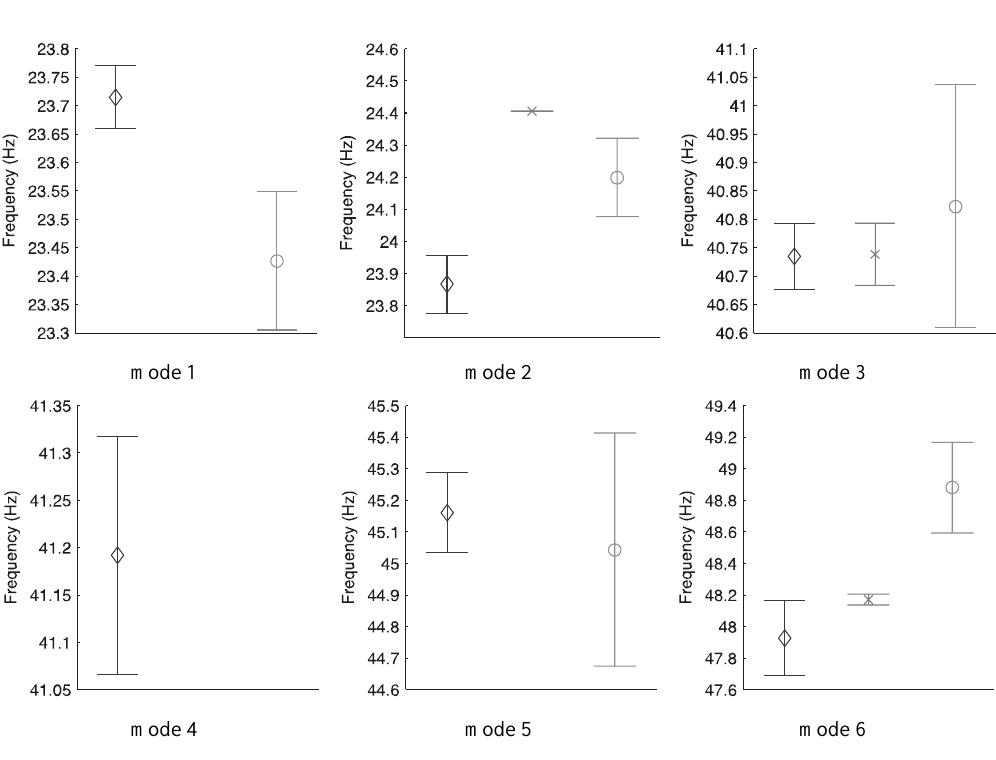
Fig. 19. Measured mode shapes of the library.